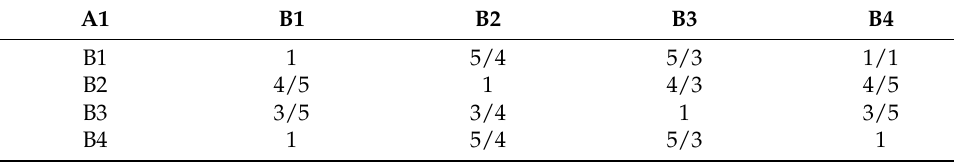
Table A4. A-B judgment matrix.